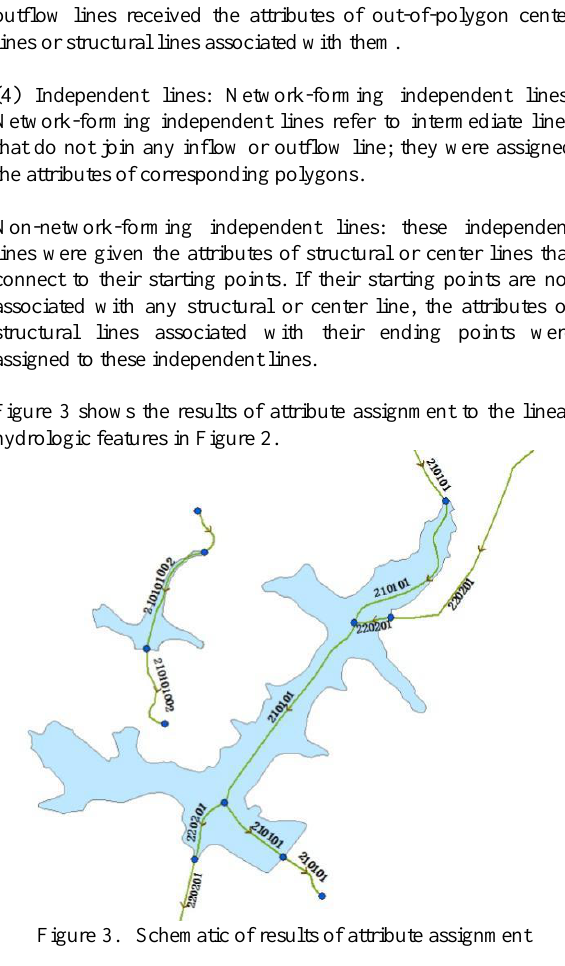
Figure 2. Flowchart showing the attribute correction process